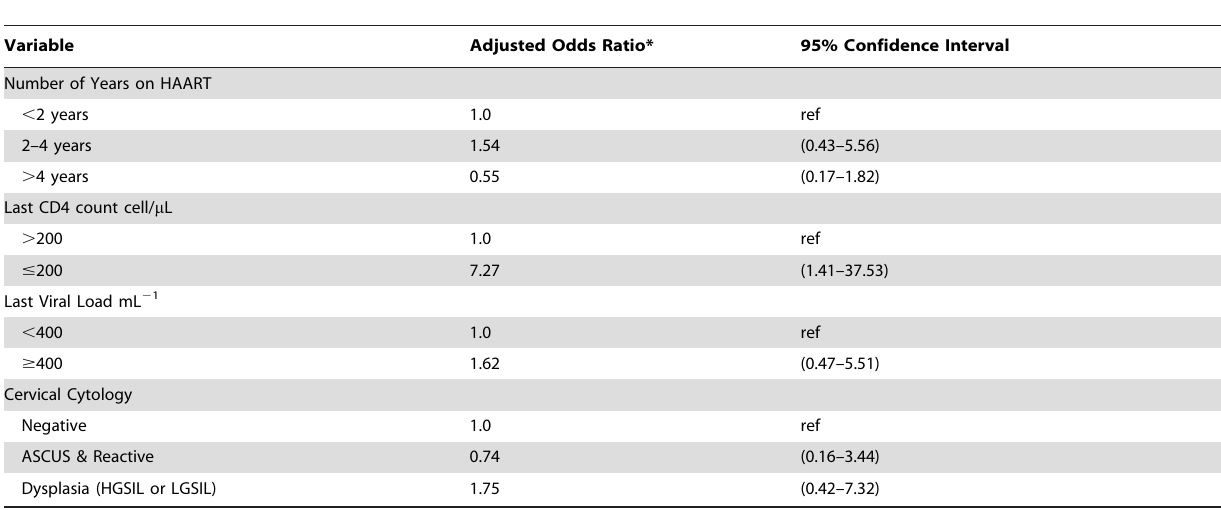
Table 2. Association between clinical factors and HR HPV infection (n=